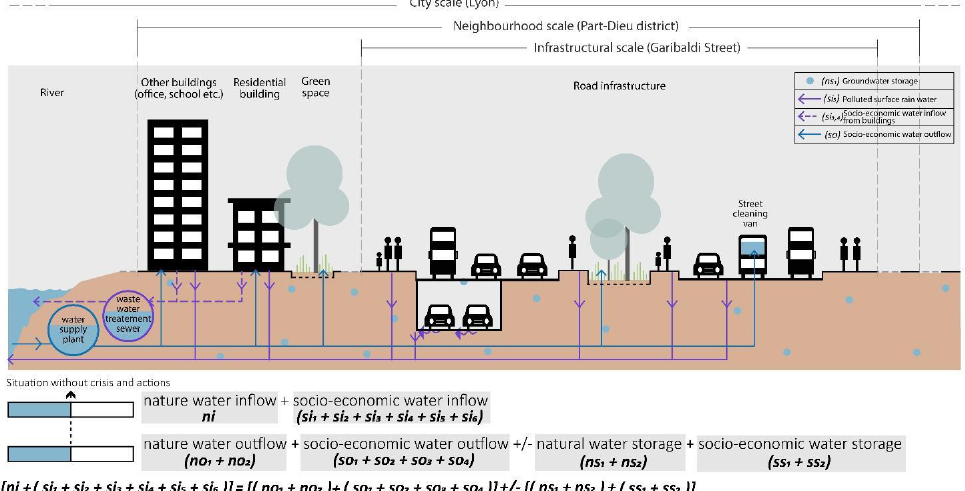
Figure 3. No-crisis situation, cognitive resilience in Part-Dieu District, realised by authors.